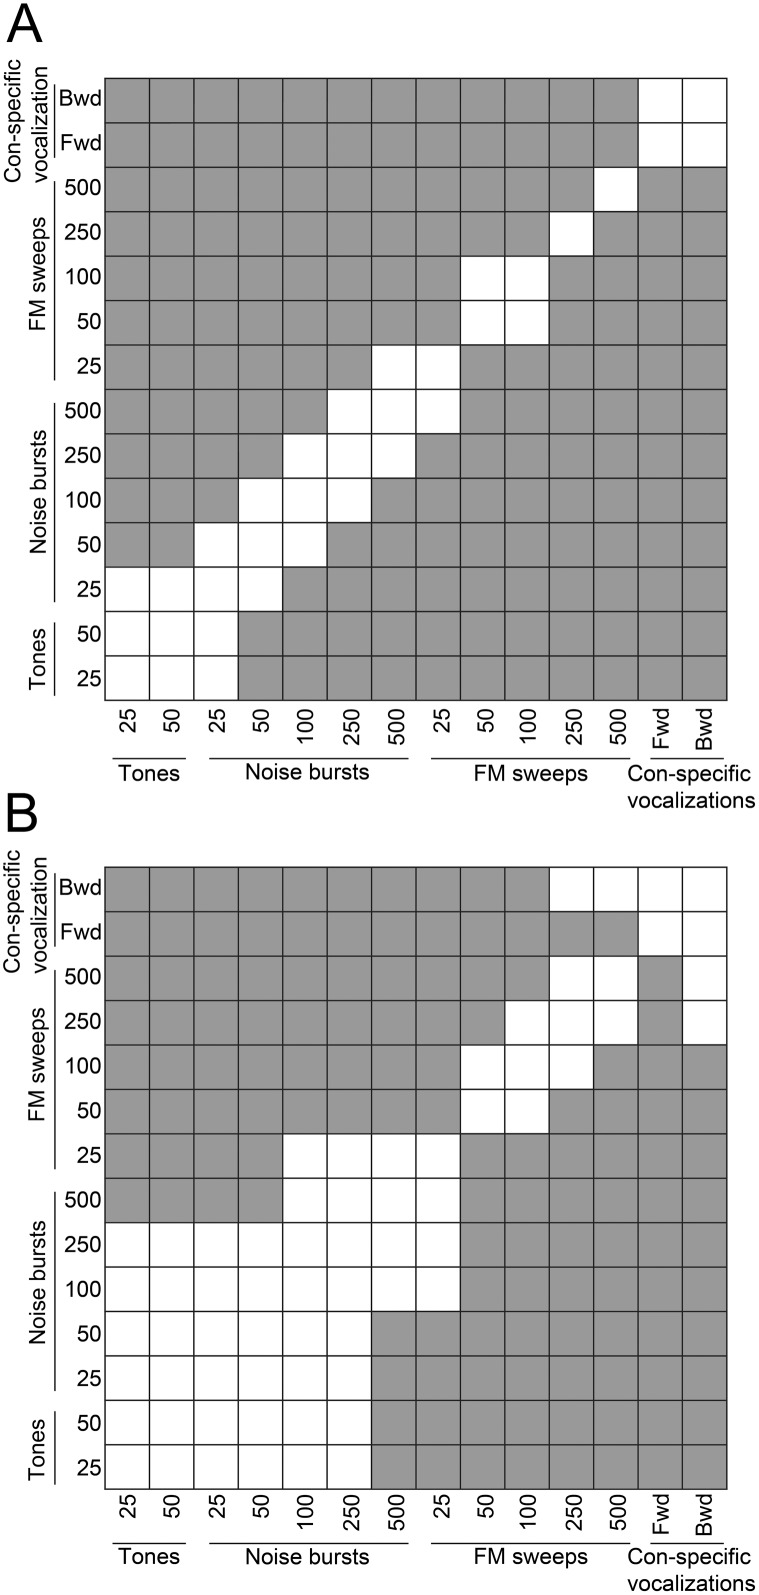
Statistical significance comparisons of neuronal response irregularity within primary auditory cortex columns as a function of acoustic stimuli.(A) Table of statistical comparisons in PSTH peak incidence across stimulus conditions. (B) Table of statistical comparisons in response similarity (cross-correlation values at time-lag zero) across stimulus conditions. Shaded squares illustrate locations of statistically significant comparisons p<0.05, ANOVA followed by Tukey-Kramer post-hoc corrections.